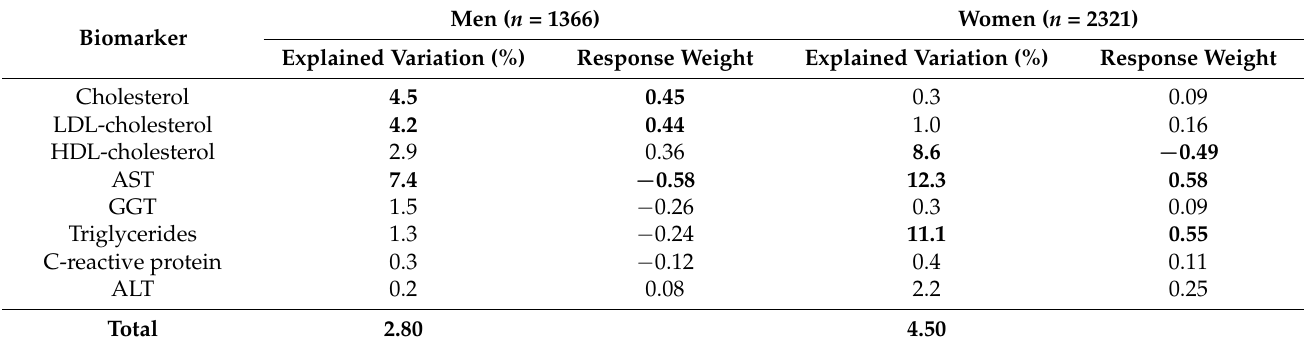
Table 5. Percentage of explained variation in the NALFD biomarkers and response weights of the RRR-derived dietary pattern scores among males and females 1